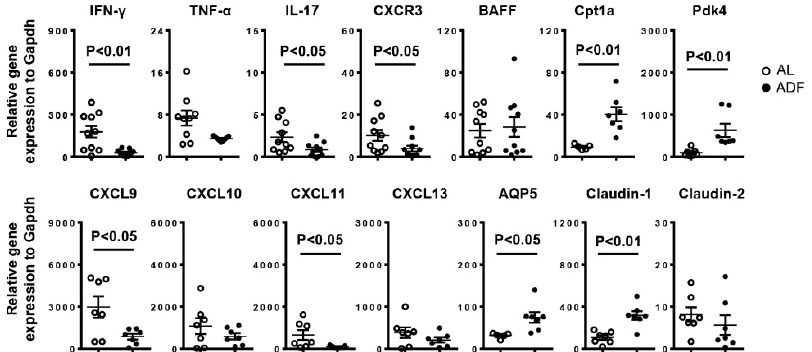
Figure 2. Alternate-day fasting (ADF) decreases T and B cell accumulation in the SMGs. 10-week- old female NOD mice were deprived of food every other day or fed with standard chow ad libitum ( AL ) for 3 weeks. ( A ) Flow cytometry profile of lymphocyte populations in the SMG cells. ( B ) The average percentage of lymphocyte subpopulations among the SMG cells. Data are representative or the average of at least 5–6 mice each group, with majority of the data generated from 7–10 mice each from group.